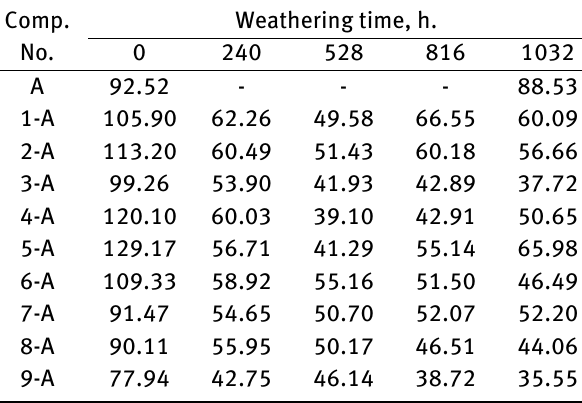
Table 7: Results of the surface microhardness (MPa) measurements after different time of the